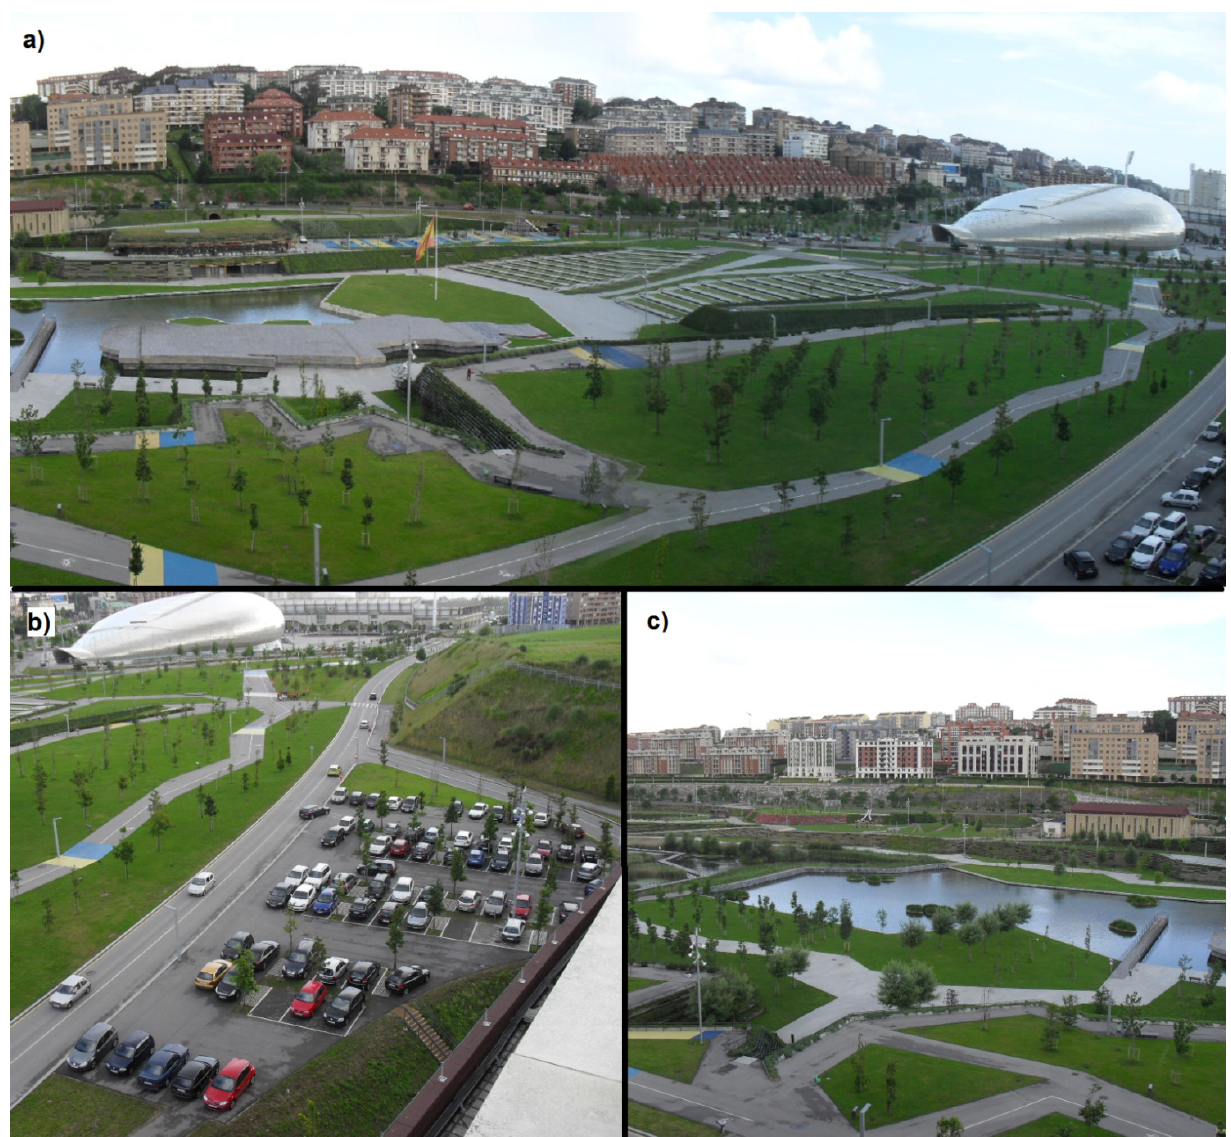
Figure 17. ( a ) La Vaguada de las llamas park; ( b ) Pervious Pavement experimental car park; ( c ) Artificial